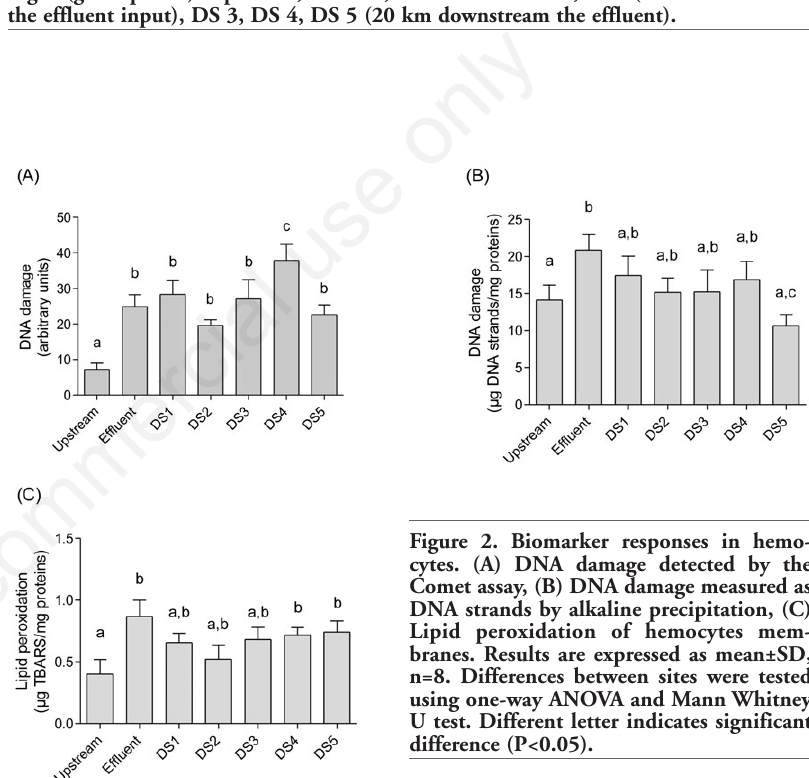
Figure 1. Location map of the study area showing the 7 studied sites where mussels were caged (green points): Upstream, Effluent, Downstream: DS 1, DS2 (10 km downstream